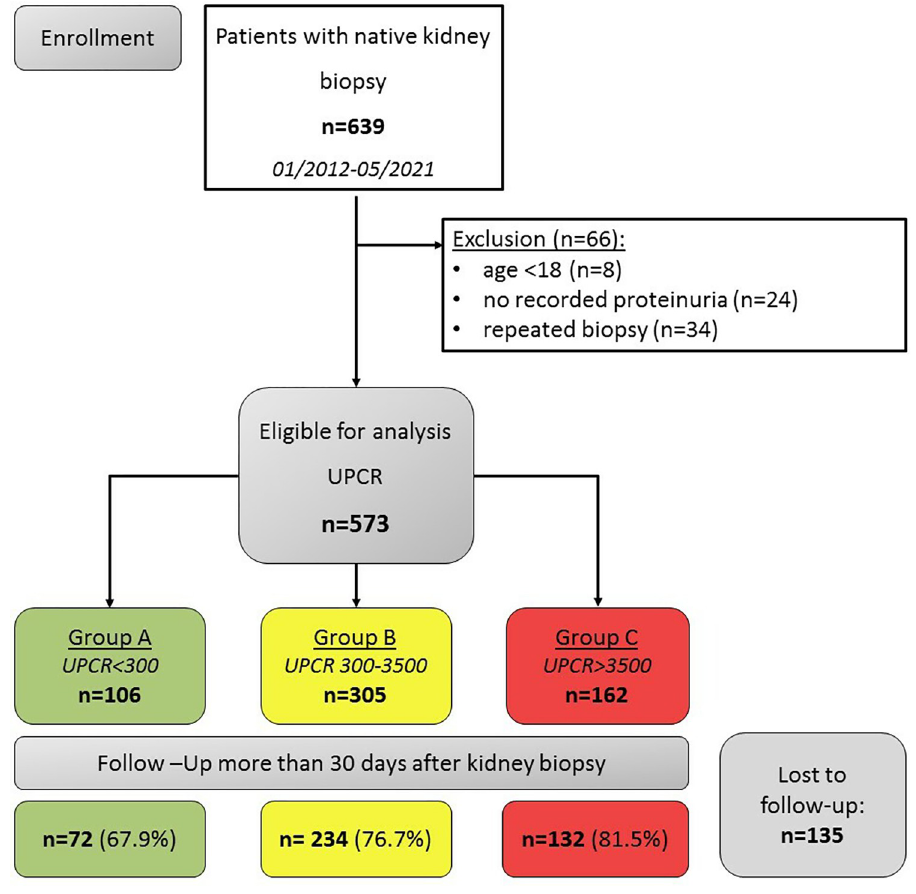
Fig 1. Recruitment flow chart. UPCR = urine protein creatinine